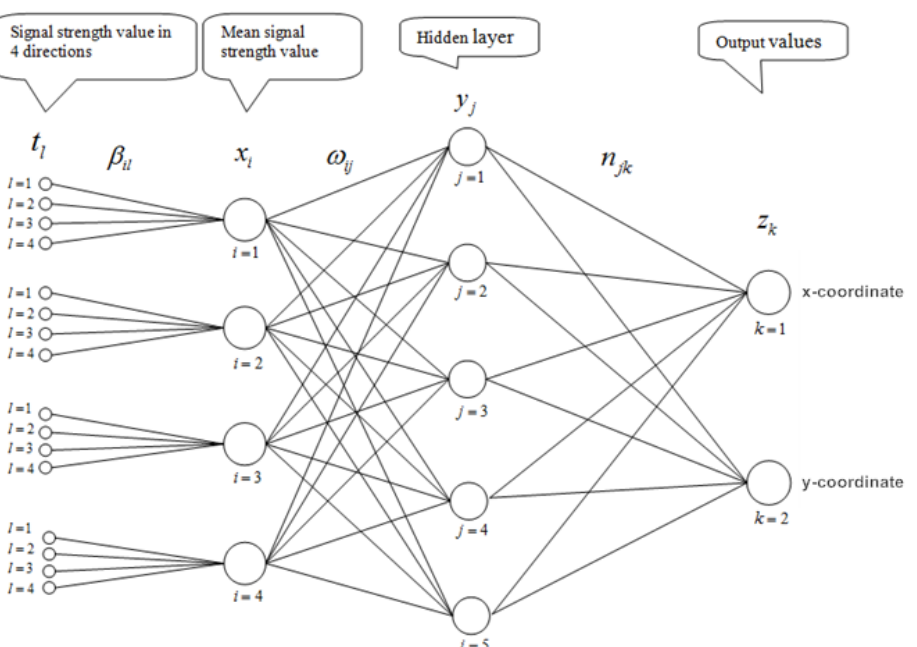
Figure 2. A three-layer feed-forward Neural Network for Wi-Fi